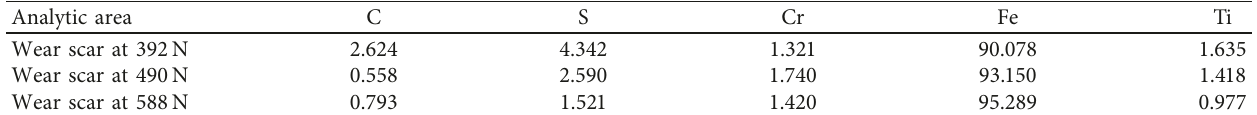
Figure 2: EDX spectra of wear scars under different loads: (a) 392N; (b) 490N; (c) 588N. Table 4: Atomic concentration (%) of elements on the wear scar by EDX.